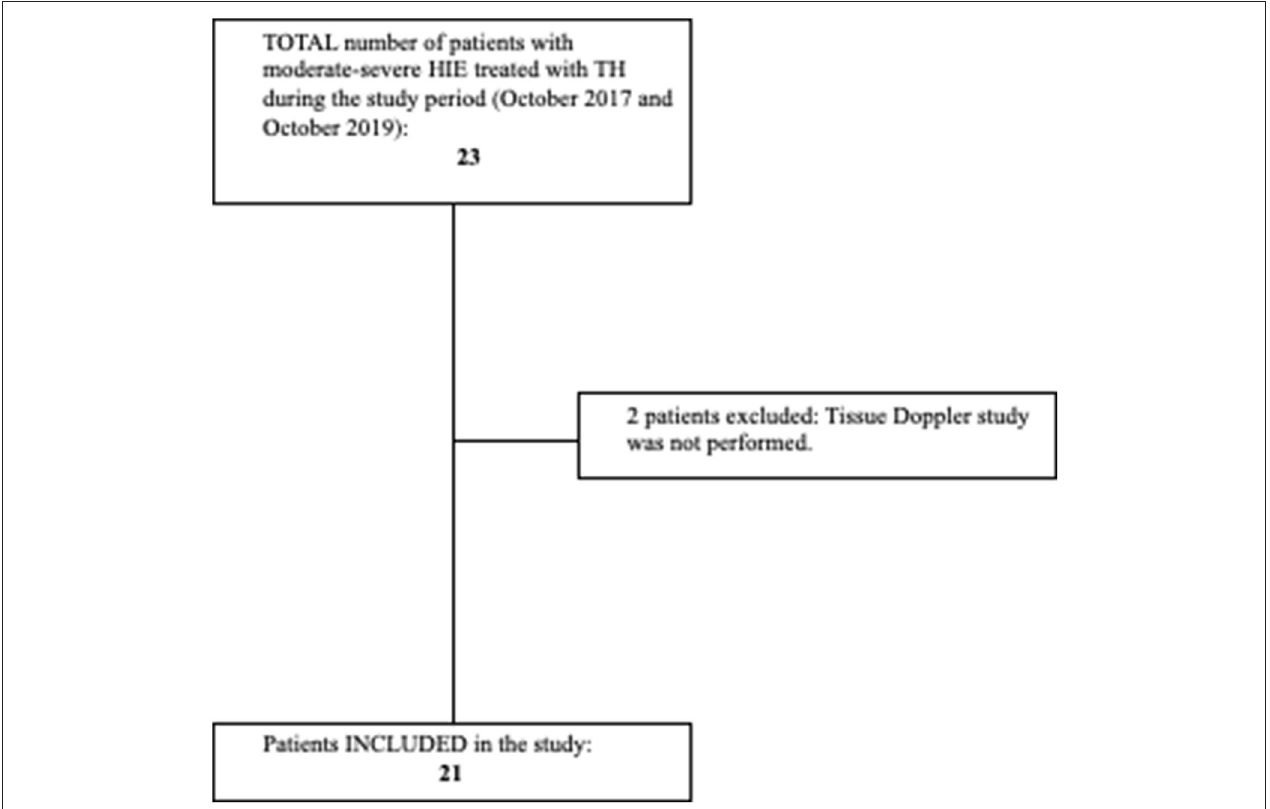
FIGURE 1 | Flowchart showing patients with hypoxic-ischemic encephalopathy (HIE) included and excluded from the study. Criteria for initiation of TH: Age < 6h, gestational age > 36 weeks, birthweight > 1,800g. Signs of moderate–severe encephalopathy according to Sarnat score, and at least one of the following: 10-min Apgar score < 5, need for resuscitation beyond 10min of life, cord pH or pH in the first h of life < 7.00, and base deficit ≥ 16 mmol/L in the first 60min of life. Target rectal temperature of 33.5 ± 0.5 ◦ C was maintained for 72h (Tecotherm Neo. Inspiration Healthcare, Leicester, UK). Rewarming was done at a rate of 0.5 ◦ C/h after cooling treatment was completed. Adapted and reprinted by permission from Springer Nature: European Journal of Pediatrics. Cerebral blood flow velocity and oxygenation correlate predominantly with right ventricular function in cooled neonates with moderate-severe hypoxic-ischemic encephalopathy ( 2). Copyright Springer